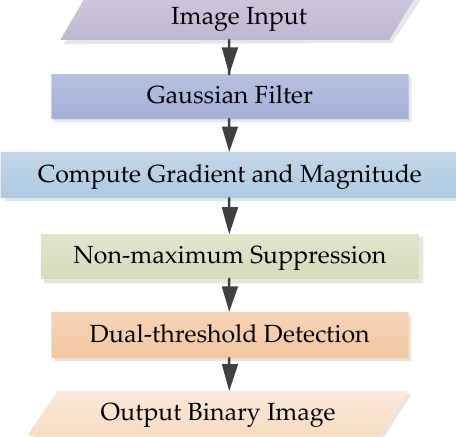
Figure 1. Flowchart of the traditional Canny algorithm.